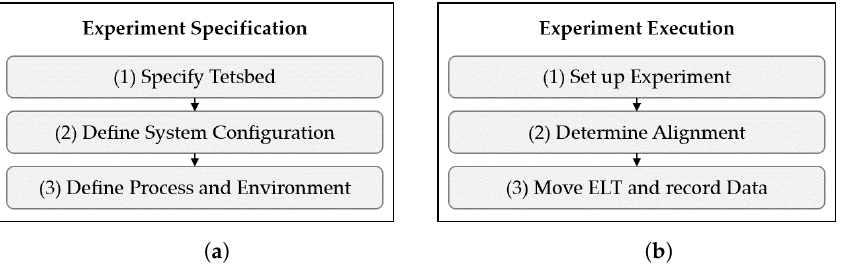
Figure 6. Functions of the module Experiment Specification ( a ) and Experiment Execution ( b